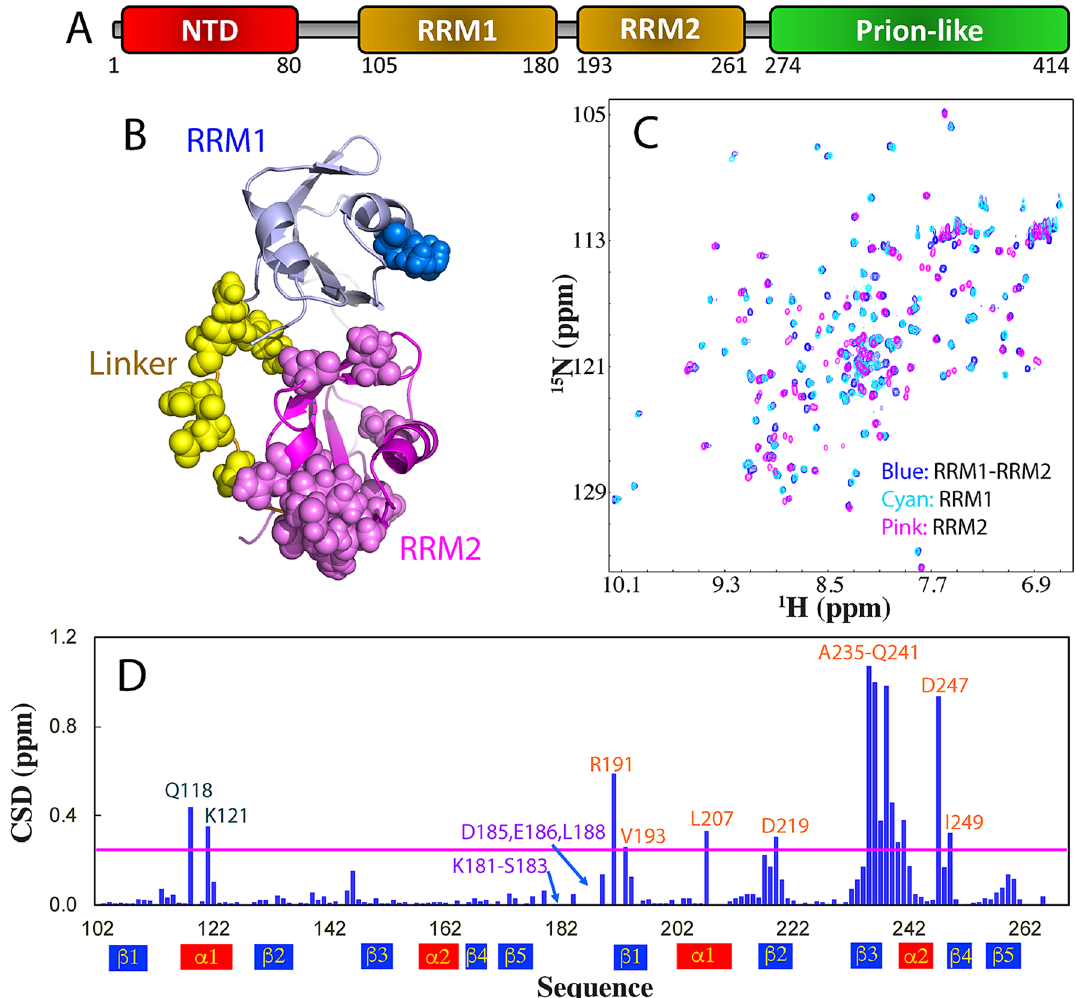
Figure 1. Dissection-induced perturbation of TDP-43 RRM domains. ( A ) 414-residue TDP-43 contains: N-terminal domain (NTD) over residues 1–80; two tandemly-tethered RNA recognition motifs (RRM1 and RRM2) over residues 105–261, and C-terminal prion-like domain over residues 274–414. ( B ) NMR structure (PDB ID of 4BS2) of the TDP-43 RRM1 (light blue) and RRM2 (pink) in which the residues are displayed in sphere for those with HSQC peaks disappeared (yellow), significantly shifted in RRM1 (blue) or in RRM2 (light pink) upon dissection. The image was prepared by PyMol2.4 (https ://pymol .org). ( C ) Superimposition of 1 H- 15 N NMR HSQC spectra of the 15 N-labeled tethered RRM1–RRM2 domains (blue), the isolated RRM1 (cyan) and RRM2 (pink) proteins at 50 μM in 10 mM sodium phosphate buffer (pH 6.8) containing 150 mM NaCl and 10 mM DTT. ( D ) Residue-specific chemical shift difference (CSD) of the RRM1 and RRM2 domains between the tethered and isolated forms. Significantly shifted residues are labeled and displayed as spheres in ( B ), which are defined as those with the CSD values > 0.25 (average value + one standard deviation) (pink